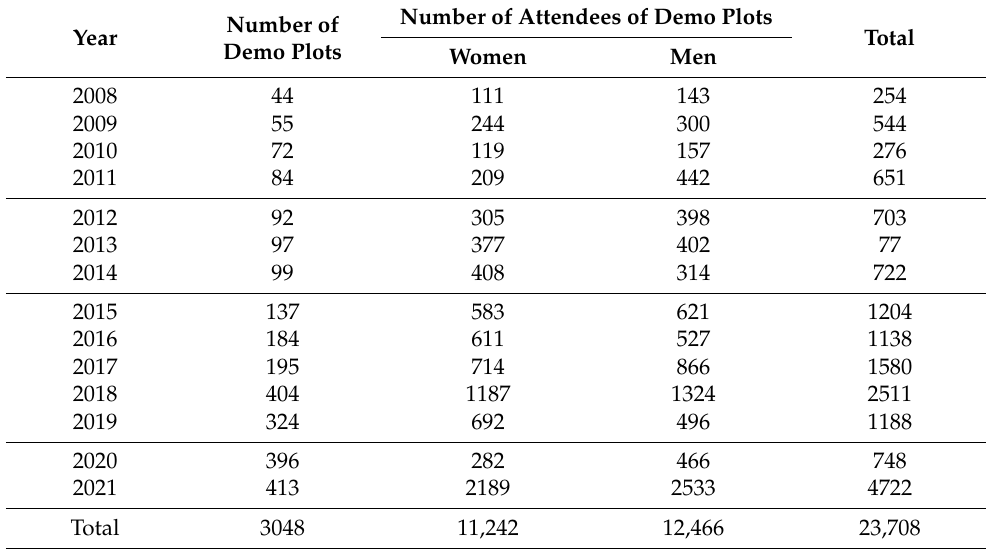
Table 4. Number of demonstration plots established at the project sites in